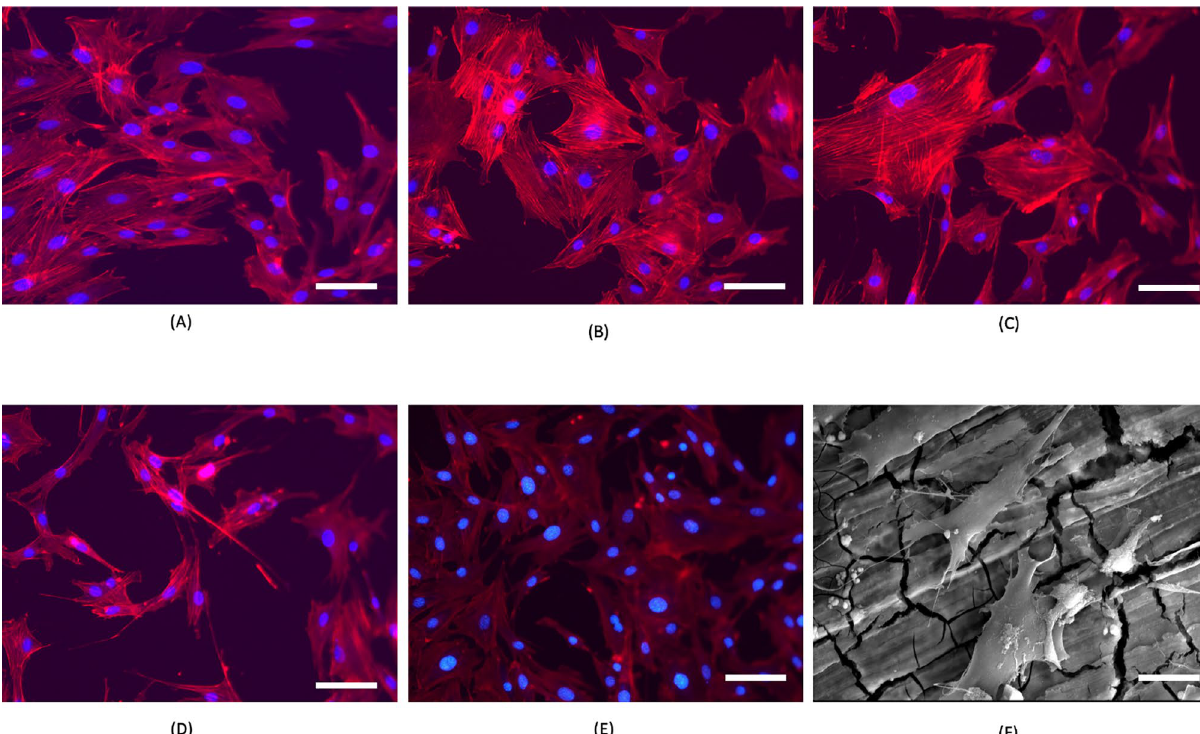
Figure 2. Cytoskeleton staining of MC3T3-E1 cells after incubation for 24 h in different alloy extracts with DAPI for nuclei (blue) and rhodamine phalloidin for F-actin stress fibres (red). Fluorescent microscope images in 20 X magnification and the scale bar indicate 50 µm. ( A ) Mg2Zn1Ca, ( B ) Mg2Zn1Ca/0.3 Mn, ( C ) Mg2Zn1Ca/0.5 Mn, ( D ) Mg2Zn1Ca/0.7 Mn, ( E ) Negative control (Media with cells were used as negative) ( F ) Morphology of MC3T3-E1 cells after incubation for 24 h. Scanning Electron microscope images. (Scale bar indicate 20